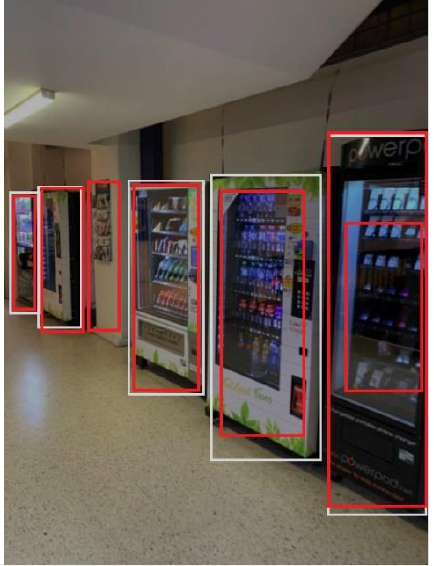
Figure 6. An example of detecting multiple vending machines in an image. The predicted bounding boxes are drawn in red while the ground truth bounding boxes are drawn in